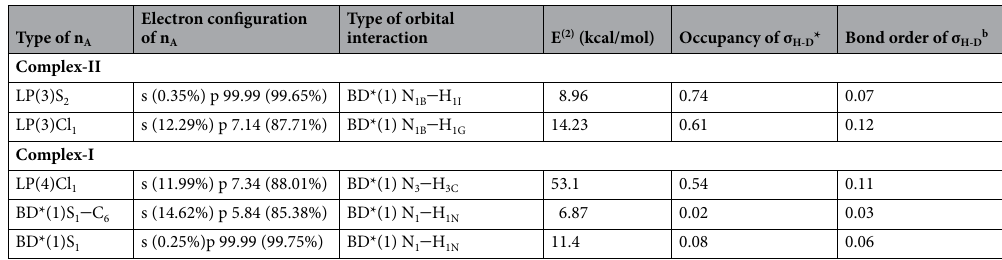
Table 4. The NBO analysis of metal–organic complexes.